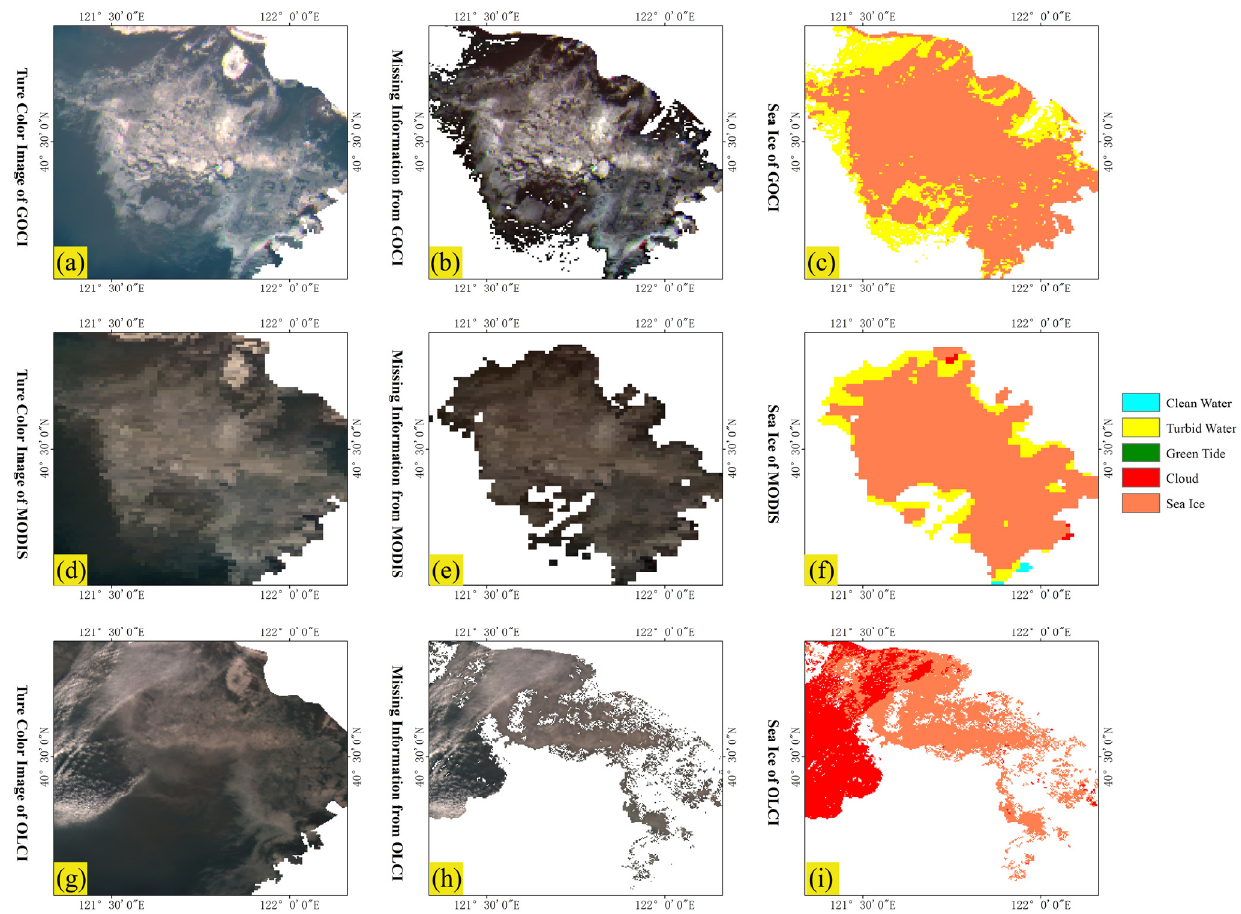
Figure 18. Schematic diagram of sea ice in the data-free areas: ( a , d , g ) the true color images at the spatial locations of the sea ice for GOCI, MODIS and OLCI data, respectively; ( b , e , h ) the condition of the data-free area; ( c , f , i ) the identifi-cation status of the marine objects in the data-free area.